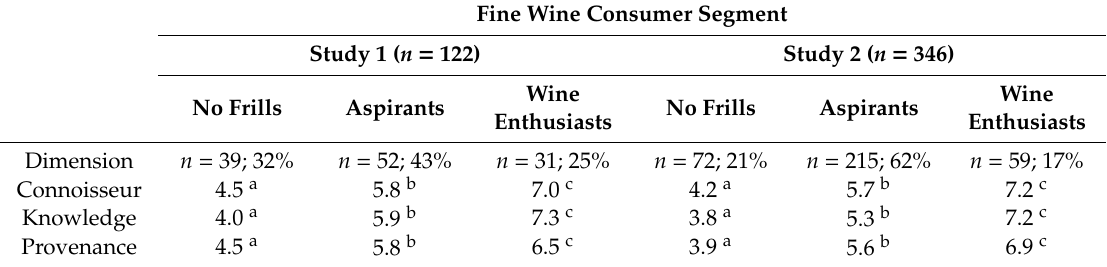
Table 1. Cluster centroids for the three fine wine segments following the Agglomerative Hierarchical Clustering